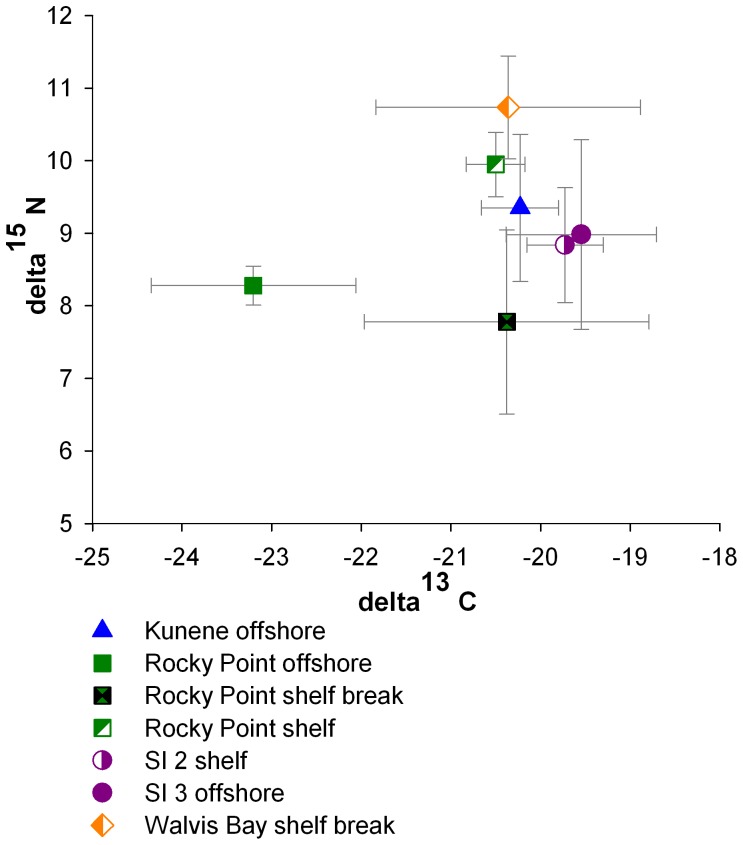
Relationship between δ13C and δ15N for various species.Mean values and standard deviations are shown.